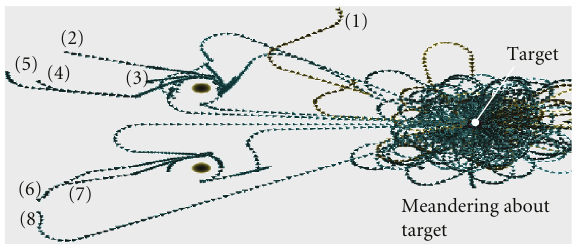
Figure 12: Eight agents flocking to the target using the multiplexed action selection scheme.